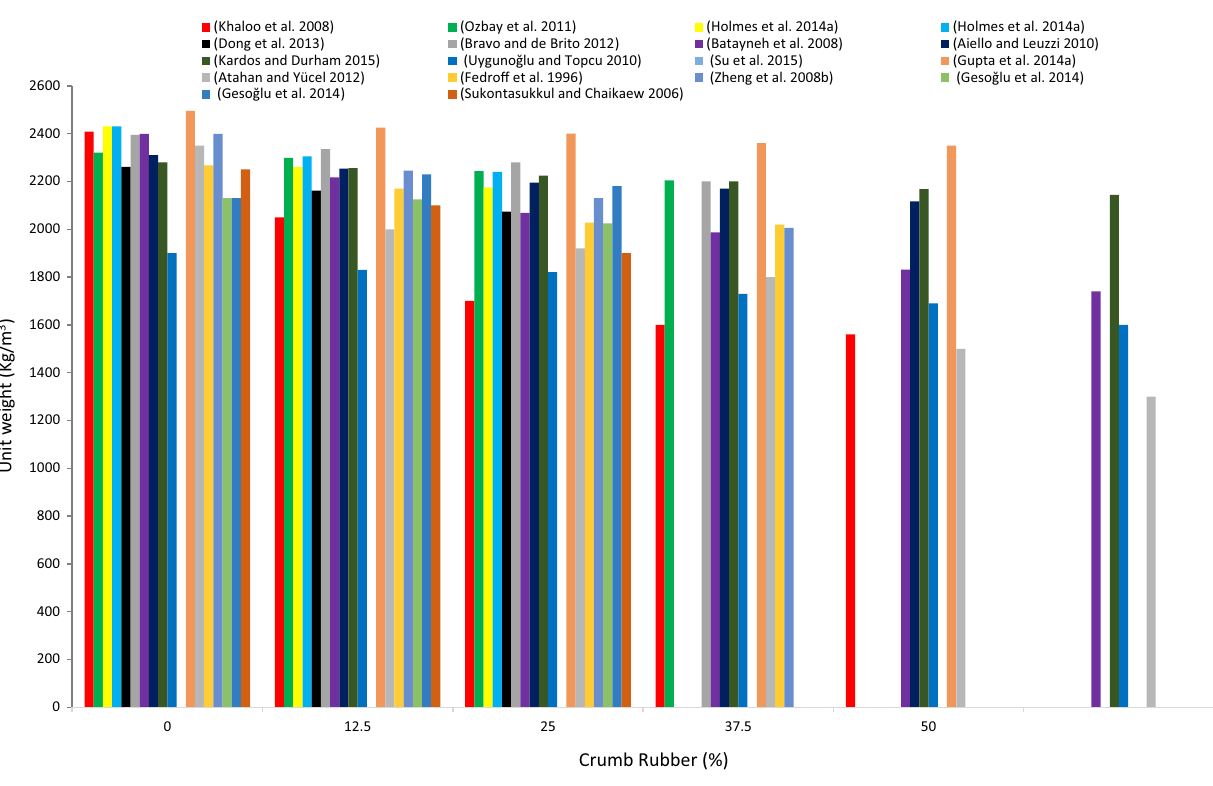
Fig. 6 Unit weight of crumb rubber concrete [8, 19, 25, 28, 28, 29, 31, 32, 32, 53, 65, 67, 95, 97, 110–112,